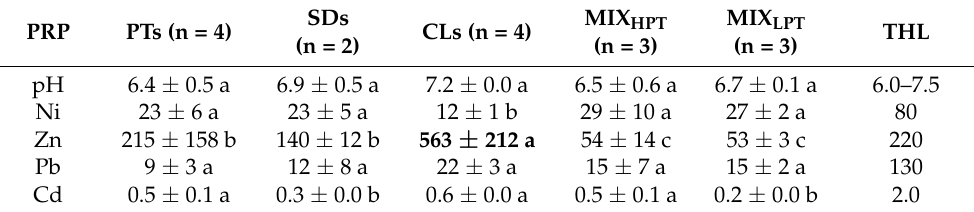
Table 3. Average pH and bulk of potentially toxic elements (PTE) (mg kg − 1 ) in the soil-like materials (PTs, valley peat); SDs, sediments; CLs, cultural layers; MIX LPT , mixture with low peat content; MIX HPT , mixture with high peat